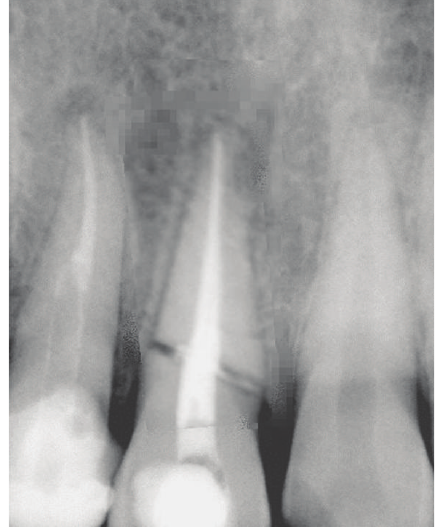
Figure 8: Working length 11.